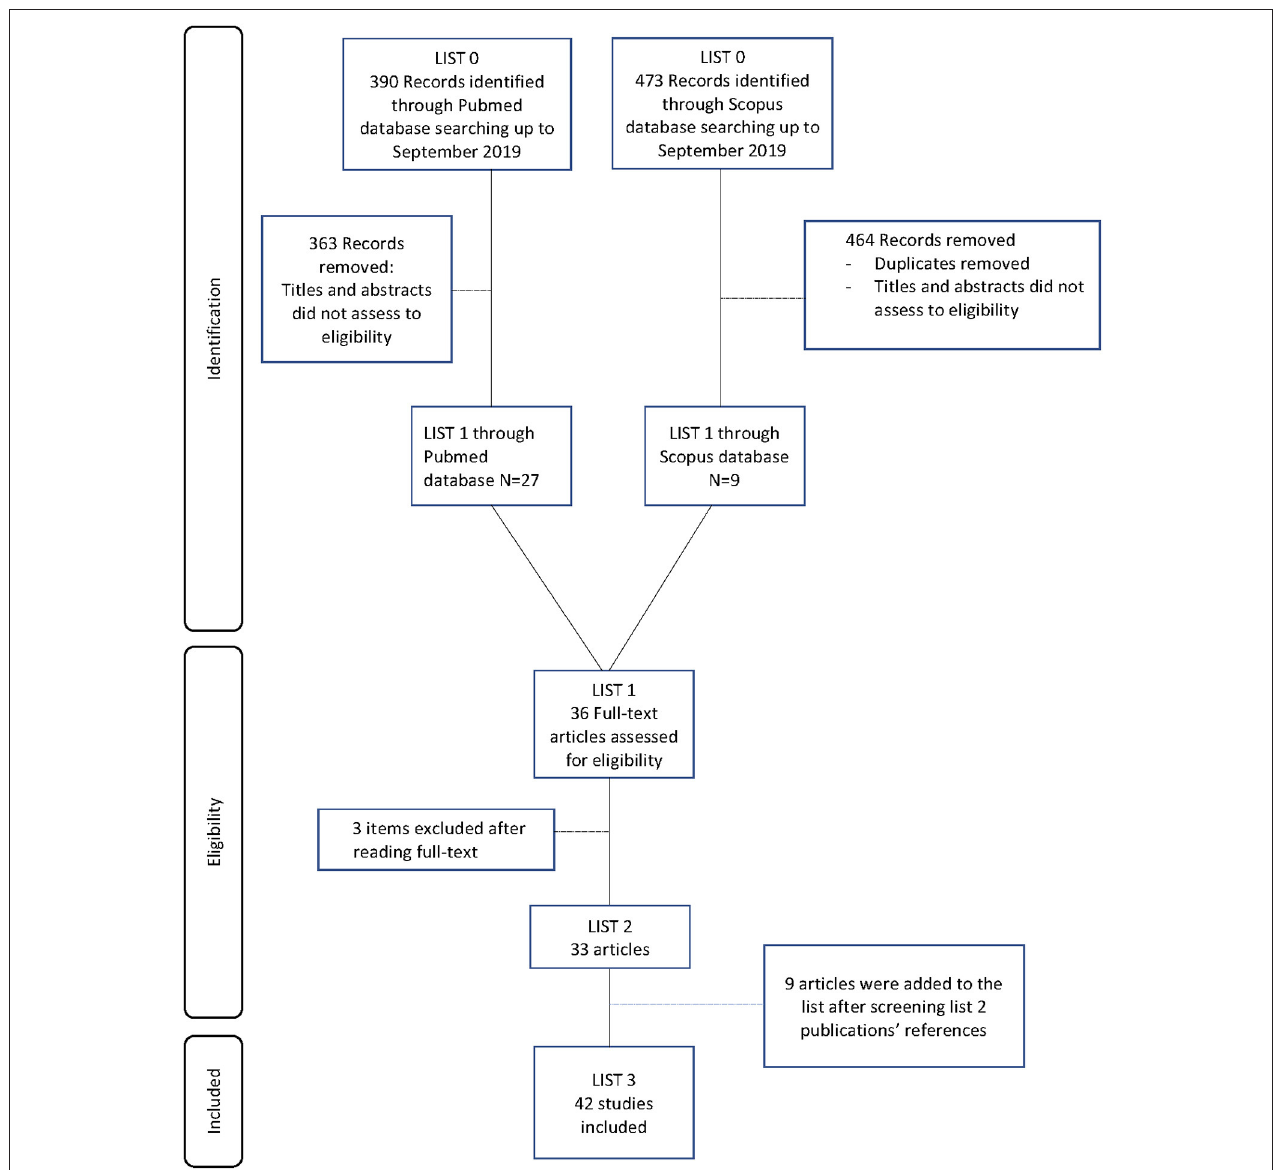
FIGURE 1 | Flow diagram of the screened